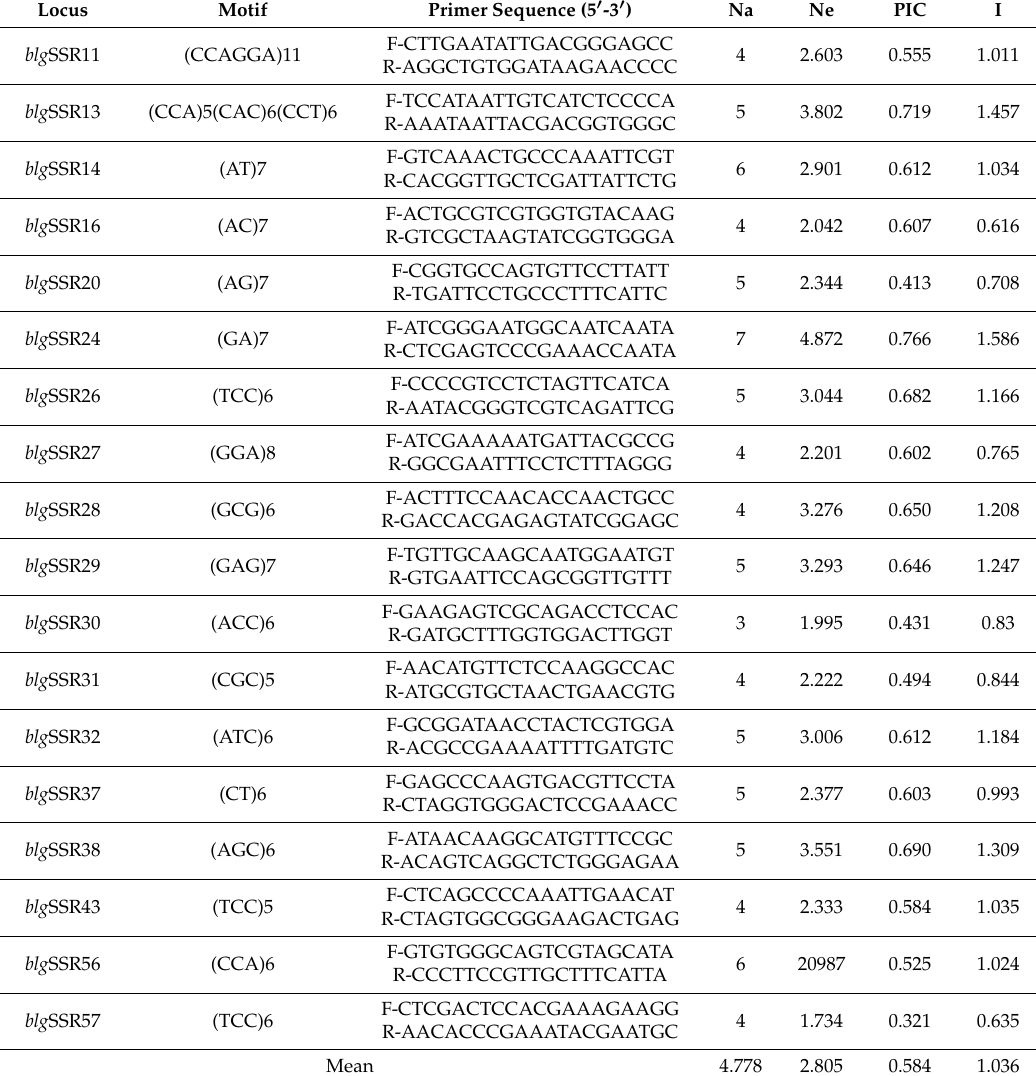
Table 4. Characteristics of 18 polymorphic SSR markers used for the phylogenetic analysis of the 37 monokaryons of